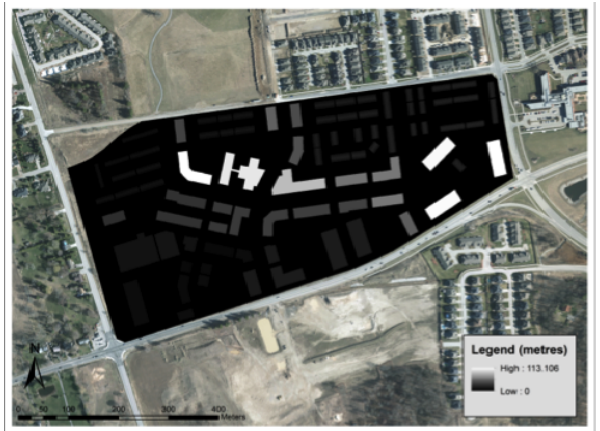
Figure 3. Original site plan design—converted 2D raster digital elevation model (DEM) at a resolution of 0.5 m converted from 3D file, projected onto